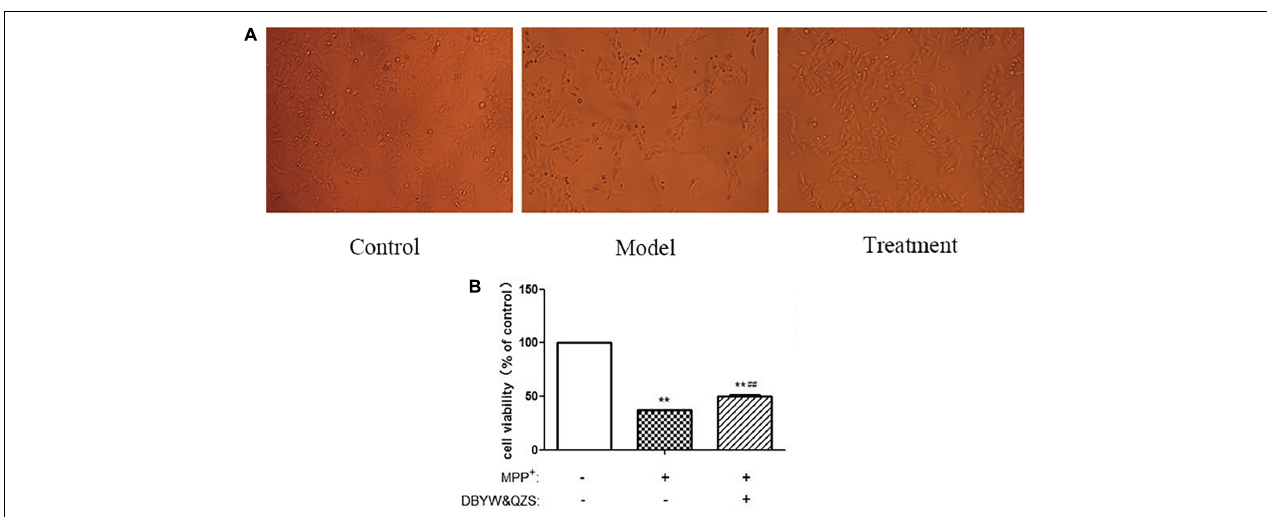
FIGURE 1 | The survival rate and shape changes of SH-SY5Y cells in each group. (A) Changes in cellular morphology were observed in cells by inverted phase contrast microscope (10). (B) . Cell viability of SH-SY5Y cells were measured after treated with MPP + (1 mM) and DBYW and QZS (5 µ g/ml). Data were expressed as mean ± standard deviation ( n = 3). Compared with the control group, ∗∗ P < 0.01; Compared with the model group, ## P < 0.01.